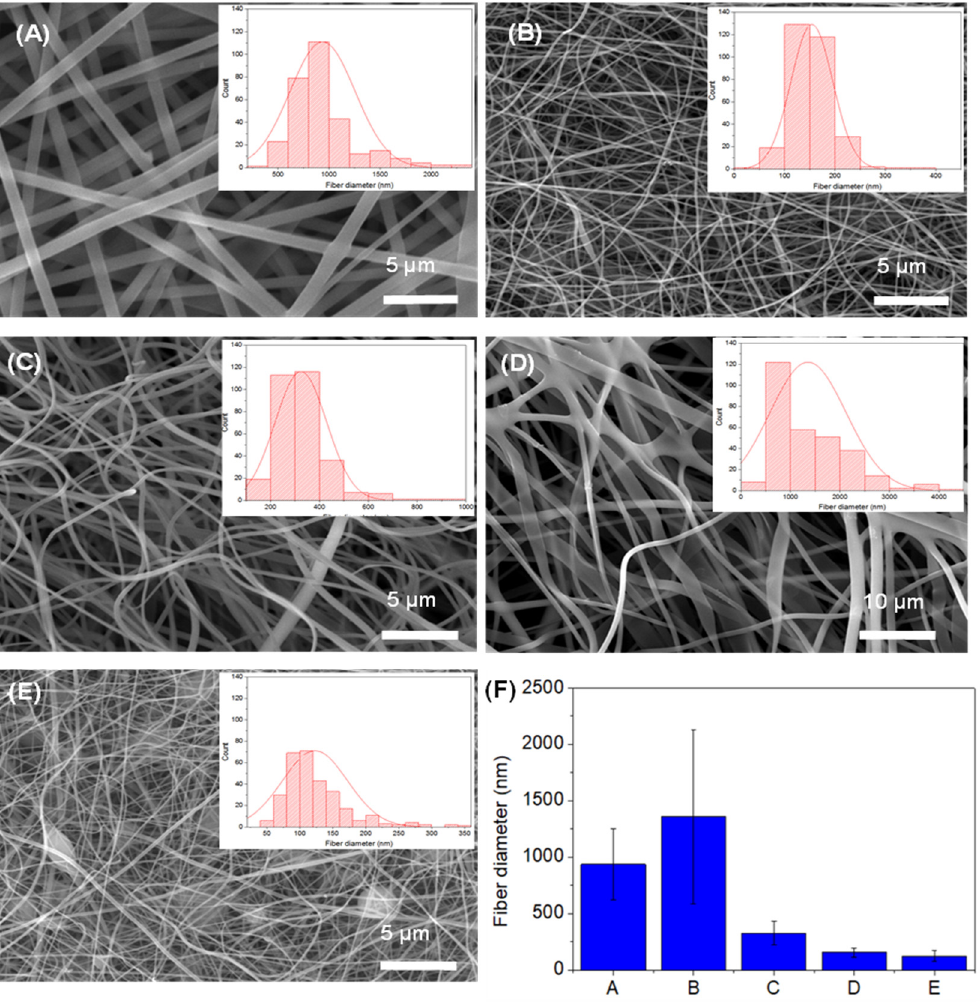
Figure 6. SEM images of PAA and PSSNa homopolymers and PAA:PSSNa copolymers EPnF meshes and the histograms representing the distribution of the fiber diameters. ( A ) PAA, ( B ) P(AA- co -SS) (70:30), ( C ) P(AA- co -SS) (50:50), ( D ) P(AA- co -SS) (30:70), ( E ) PSSNa and ( F ) Fiber size distribution graphs in all EPnF samples. The capital letters of A, B, C, D and E in the subfigure (F) indicate PAA, P(AA- co -SS) 70:30, P(AA- co -SS) 50:50, P(AA- co -SS) 30:70 and PSSNa, respectively.